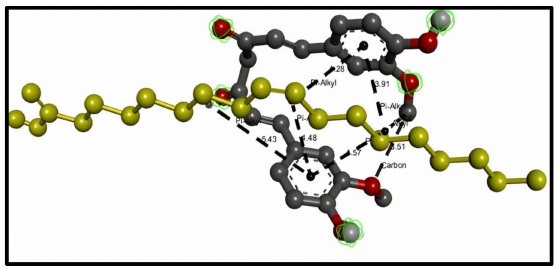
Figure 2. 3D interaction between curcumin molecule (gray) and oleic acid oil (yellow). The formed bonds are described as black short